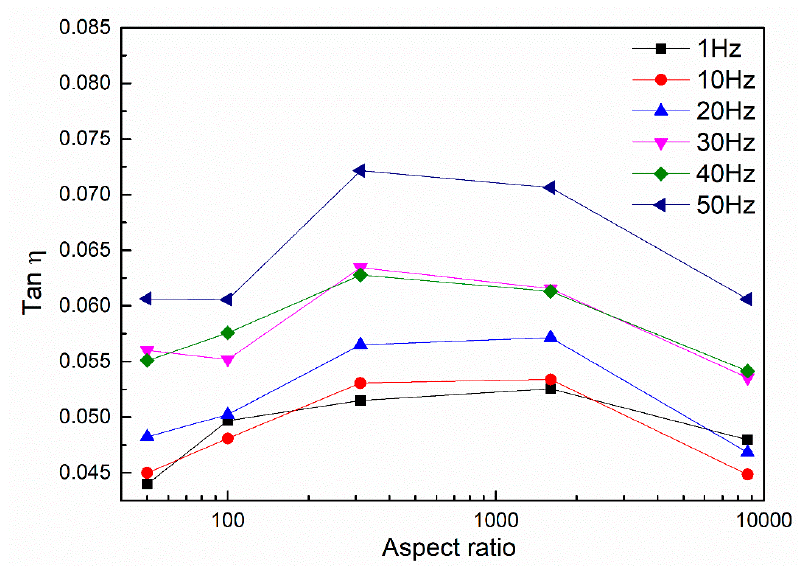
Figure 8. Relationship between loss factor and aspect ratio of MWCNTs at the frequency range of 1–50 Hz.